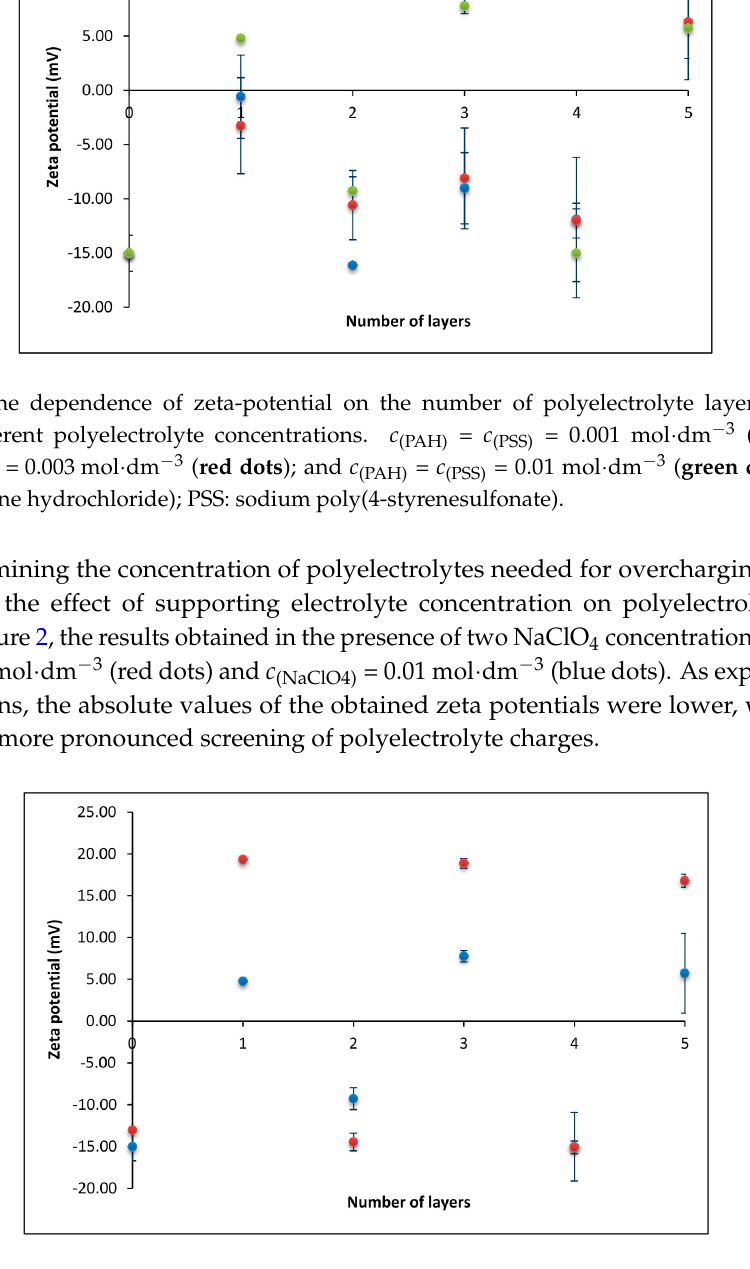
Figure 2. The dependence of zeta potential on the number of polyelectrolyte layers obtained at two different salt (NaClO 4 ) concentrations: c = 0.001 mol·dm − 3 ( red dots ); and c = 0.01 mol·dm − 3 ( blue dots ).